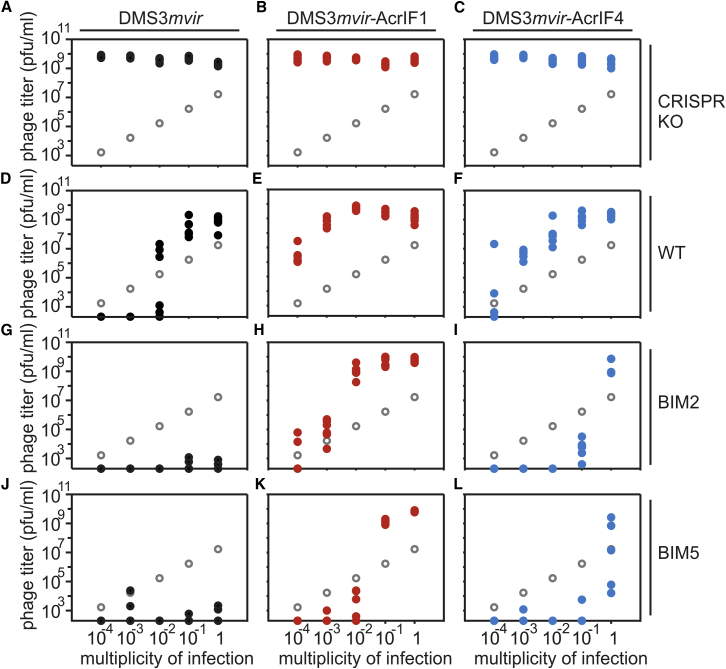
The Initial MOI of Acr-Phage Determines the Epidemiological Outcome(A–L)Viral titers at 24 hr post-infection (hpi) with DMS3mvir (A, D, G, and J), DMS3mvir-AcrIF1 (B, E, H, and K), or DMS3mvir-AcrIF4 (C, F, I, and L) of PA14 CRISPR-KO (A–C), WT (D–F), BIM2 (G–I), or BIM5 (J–L). Gray circles indicate the phage titers at the start of the experiment (corresponding to the addition of 104, 105, 106, 107, or 108 pfus). Colored data points represent phage titers at 24 hpi; each data point represents an independent biological replicate (n = 6). The limit of detection is 200 pfu/ml.See also Figure S2.